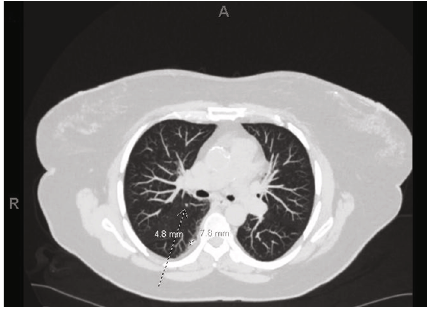
Figure 1: Screening chest computed tomography (CT) scan revealed multiple bilateral pulmonary nodules, measuring up to